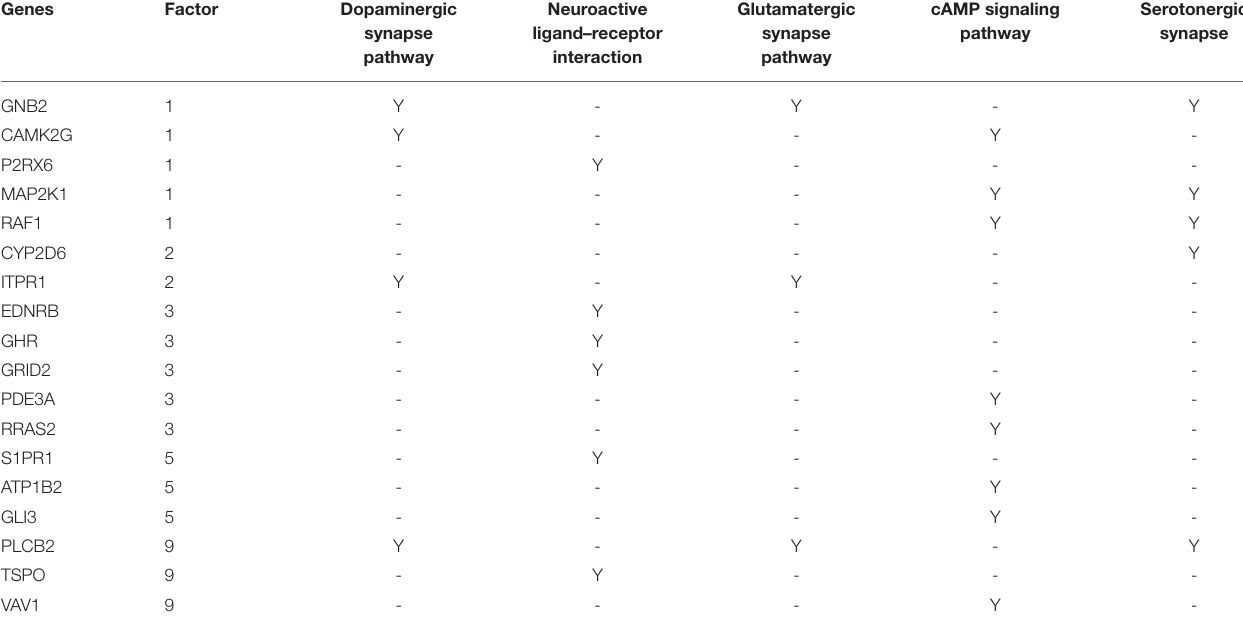
TABLE 1 | Results from an integrative analysis uncovering 18 schizophrenia-associated candidate genes and corresponding pathways. Genes